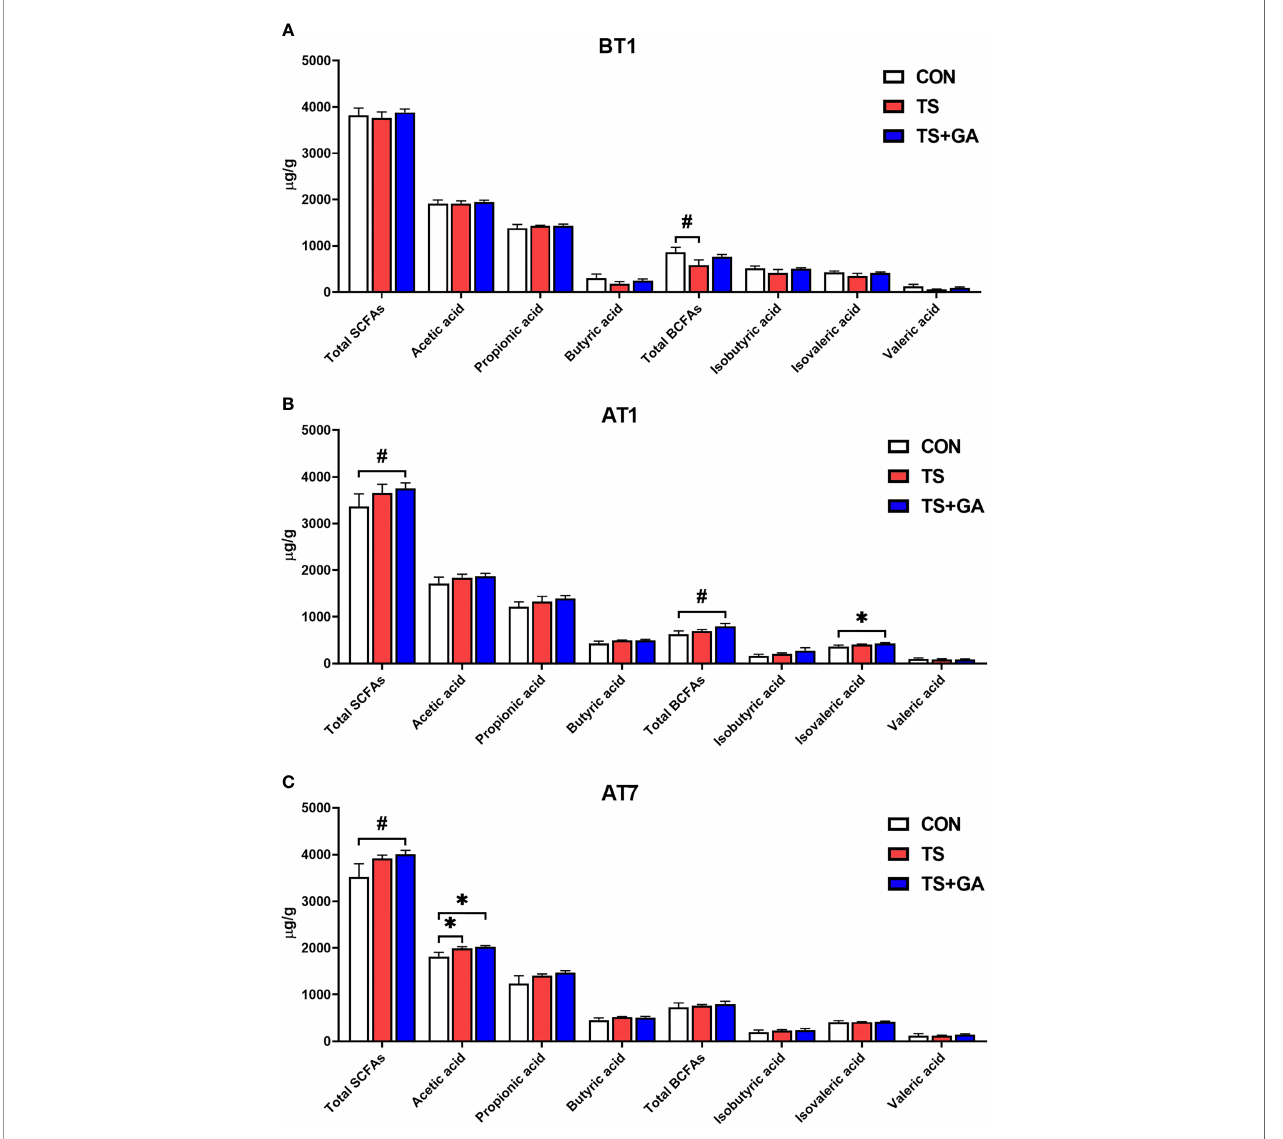
FIGURE 5 | Effect of gallic acid (GA) on fecal short-chain fatty acids (SCFAs) and branched-chain fatty acids (BCFAs) in puppies on BT1 (A) , AT1 (B) , and AT7 (C) (n = 6 or 7). The symbol (*) indicates statistically signi fi cant differences between two groups (* p < 0.05), and the symbol (#) represents difference tendency (# p < 0.10). BT1, the 1st day before transportation; AT1, the 1st day after transportation; AT7, the 7th day after